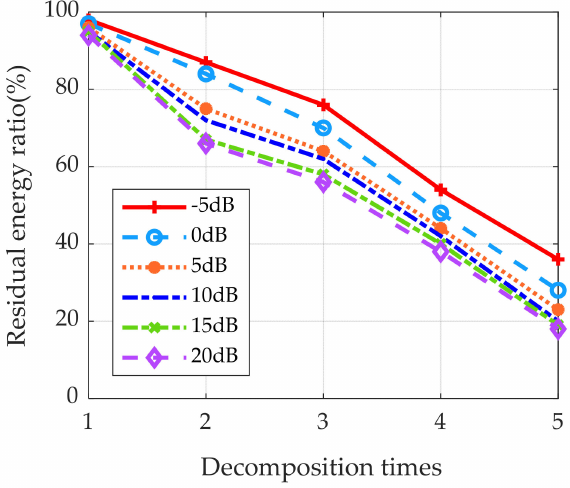
Figure 9. Variation curves of residual energy ratio after atomic dictionary decomposition under different SNR